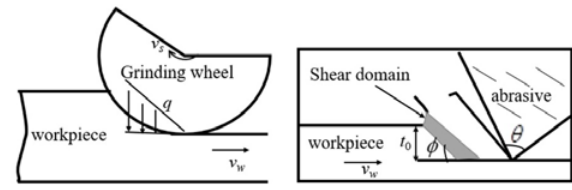
Fig. 1. Geometric relationship of grinding